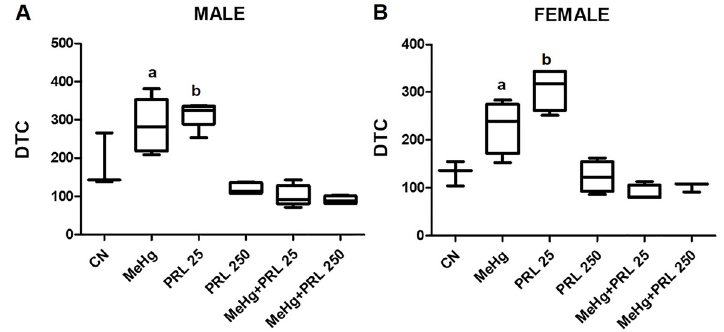
Figure 2. Degree of tissue change (DTC) in the liver in each treatment group for ( A ) males and ( B ) females. Data are reported as medians and interquartile range. a P o 0.01 compared to all other treatment groups (except the PRL 25 group); b P o 0.01 compared to all other treatment groups (except the MeHg group) (ANOVA with Tukey ’ s post-test). CN: Control group; MeHg: methylmercury; PRL 25 and PRL 250: 25 and 250 m g/kg prolactin, respectively, every 12 h.